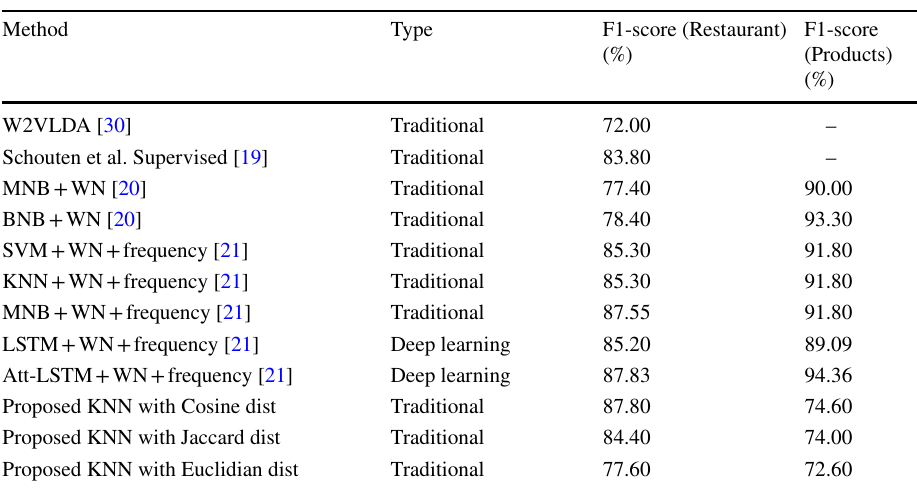
Table 7 F1-score performances of selected traditional and deep learning approaches and our proposed methods for IAI and using Restaurant and Products